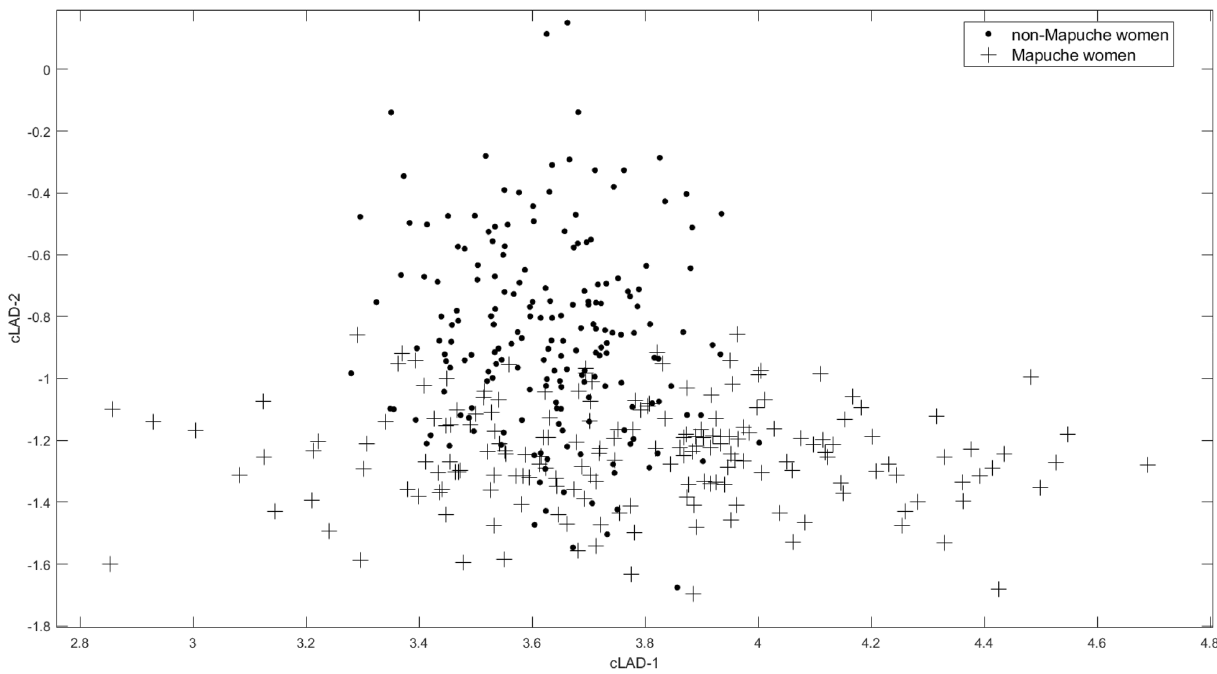
Figure 1. Projections in coordinate system defined by the two cLAD linear marker combinations Crosses represent Mapuche women and dots represent non-Mapuche